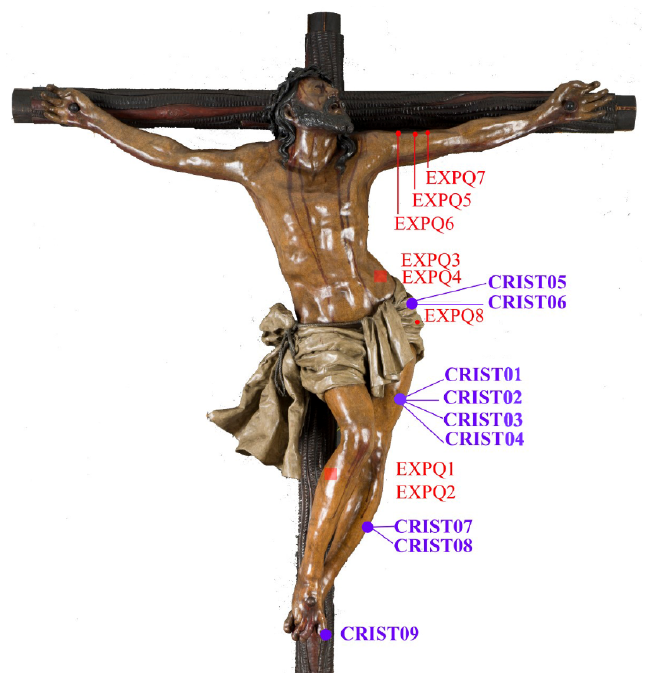
Figure 2. General view of Christ of Expiration and location of the different analyses. XRF-XRD zone of the study (code CRISTxx in purple) and traditional sampling (code EXPQx in red) in the surface of the Christ of Expiration.